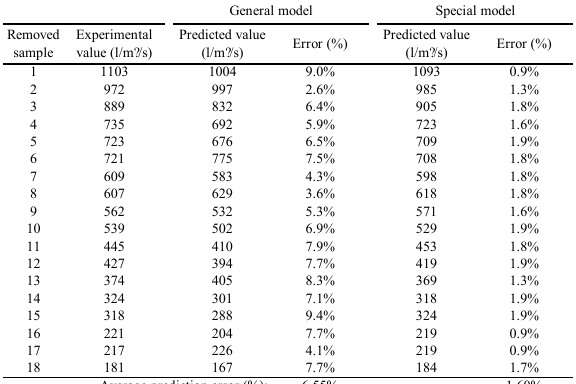
Table 3. Experimental results on the functional property “water permeability” for three product families.